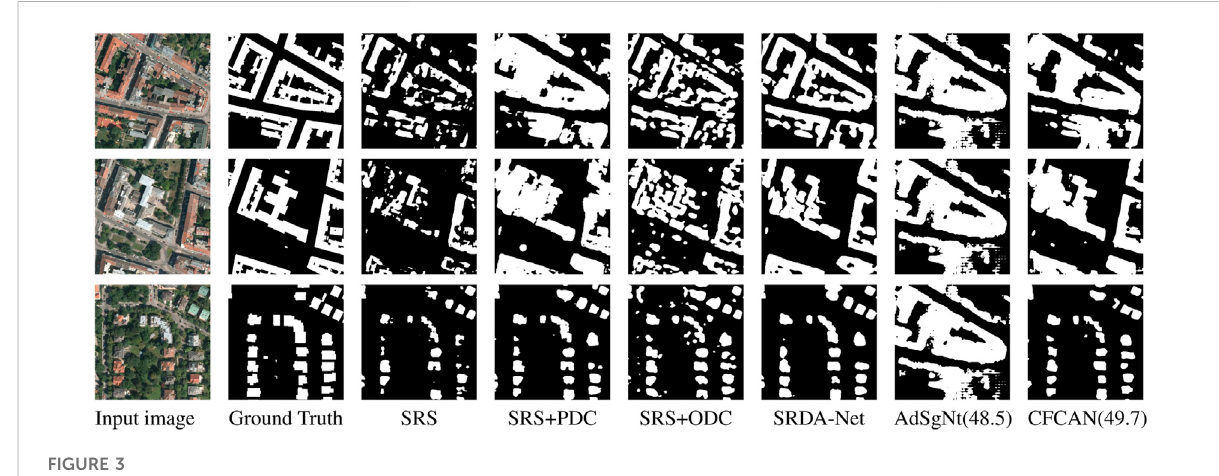
FIGURE 3 Qualitative results of the Inria val dataset (Source domain: Massachusetts Buildings).